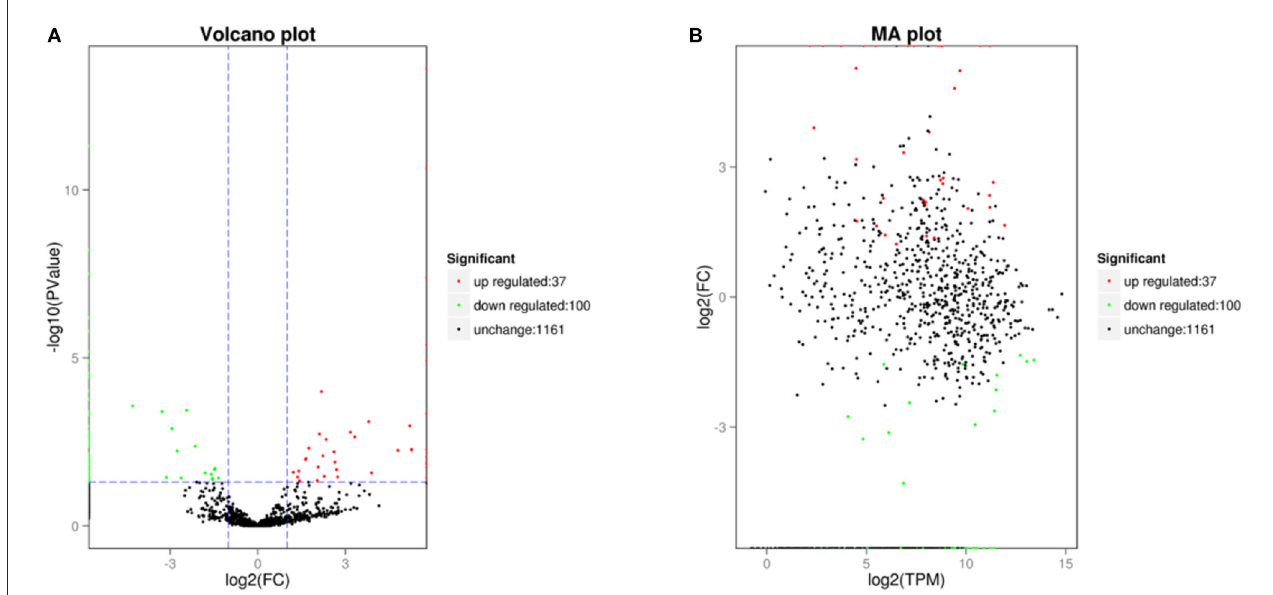
FIGURE5 DE circRNAs plot. (A) is a volcano diagram of DE circRNA, that each point in the diagram represents a circRNA. (B) is a DE circRNA MA plot and each point in the diagram represents a gene.